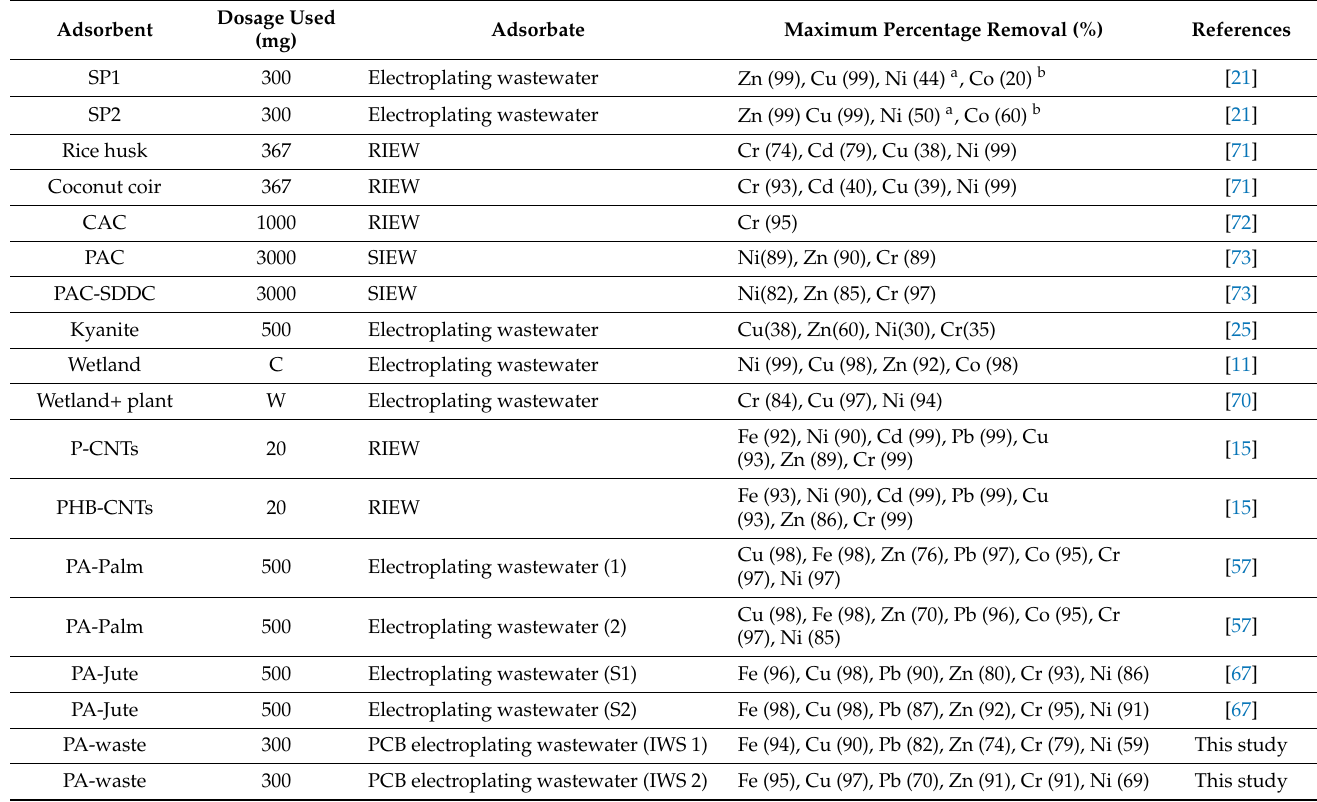
Table 7. Percentage removal of different adsorbent on various types of electroplating